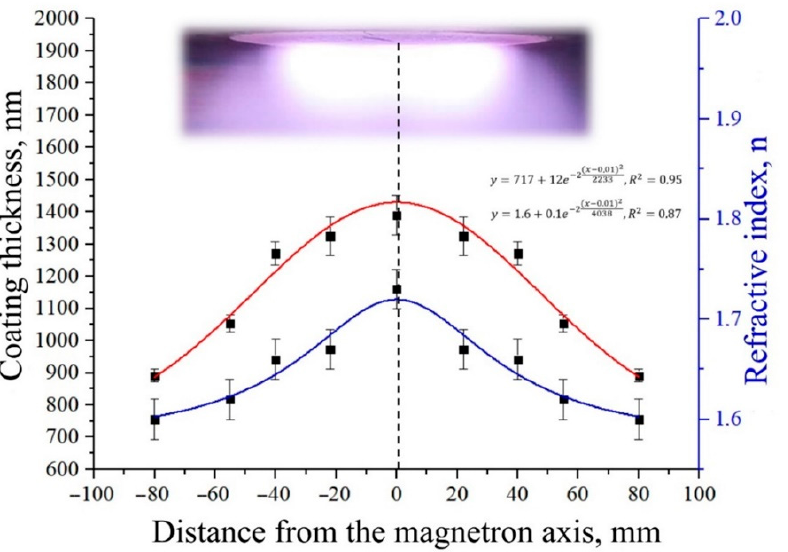
Figure 8. Thickness and refractive index distribution n of the CaP coating deposited from a Cu-HA target on the surface of the substrate holder.